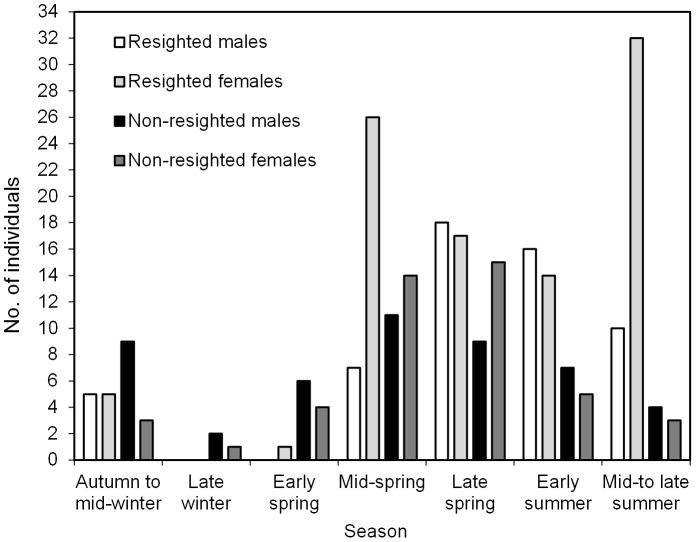
Average daily ‘operational sex ratio’ (OSR) by season in humpback whales identified off west South Africa.Whales were identified from tail fluke and dorsal fin pictures and microsatellites collected during boat encounters. Data shown for both those whales only seen once (n = 93) and those resighted (51 individuals in 151 sightings); calves of the year were excluded.